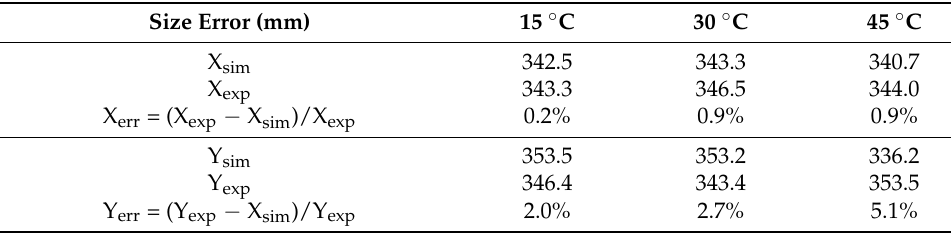
Table 5. Comparison error between simulation and